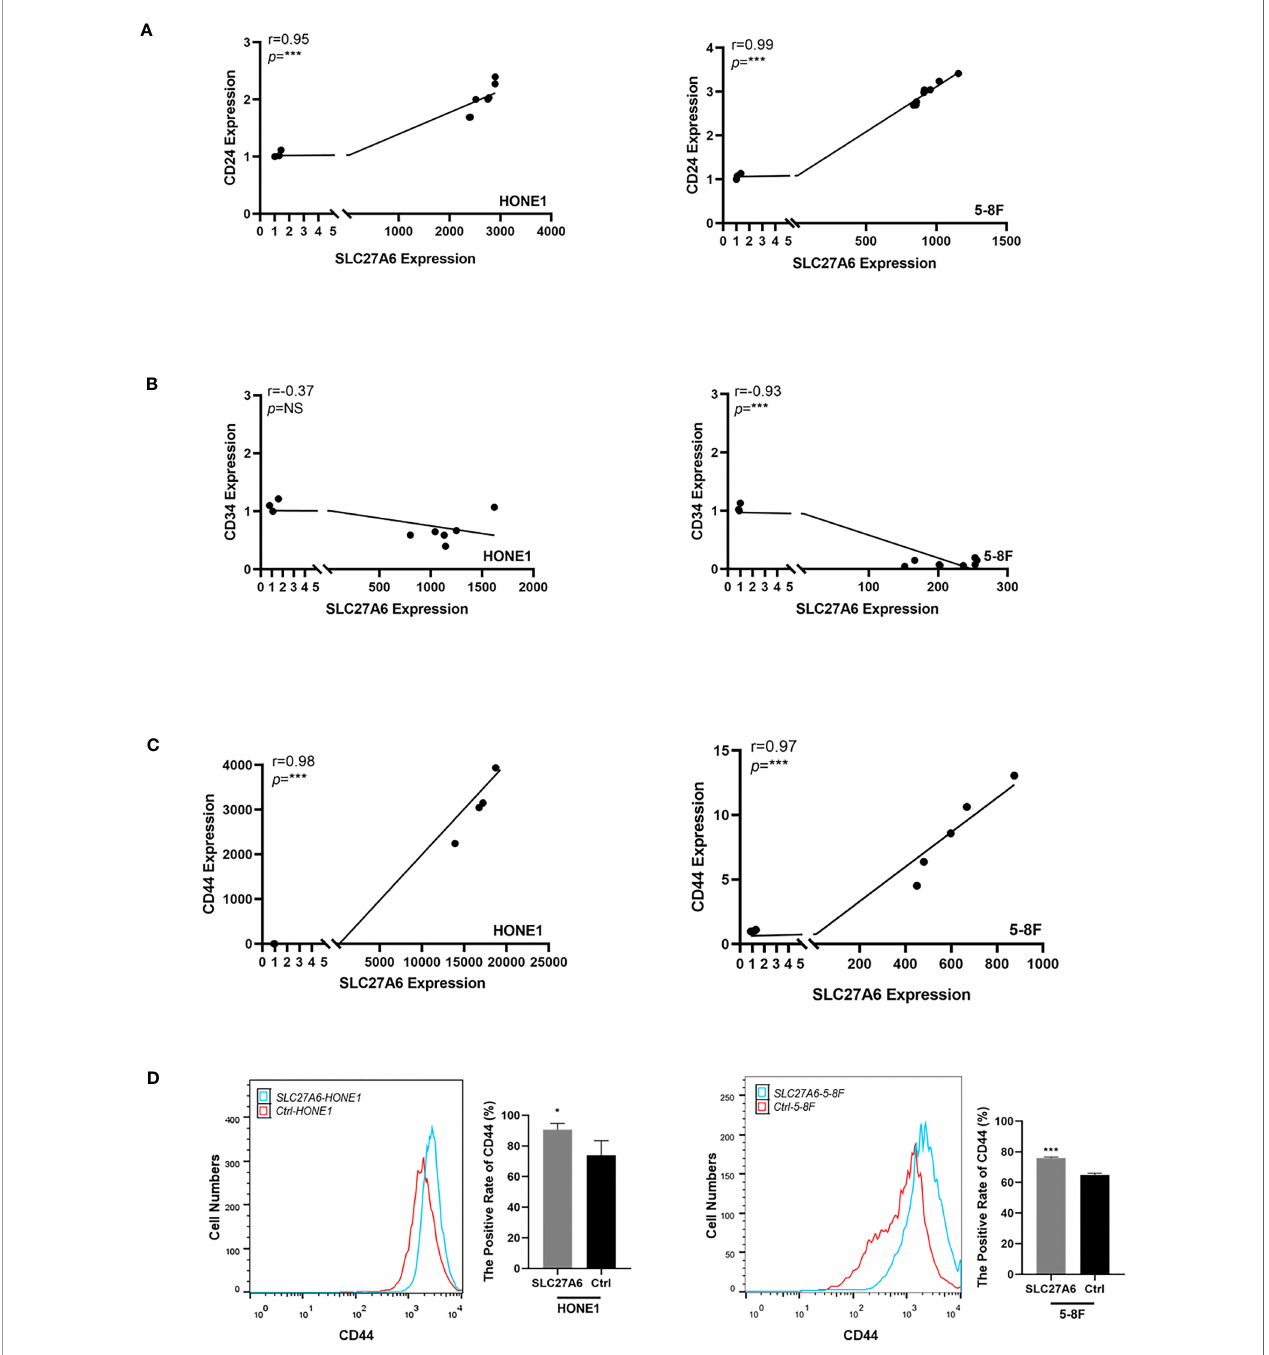
FIGURE 7 | SLC27A6 expression positively correlates with CD24 and CD44 expression level in NPC cells. (A) Positive correlation between the mRNA expression of SLC27A6 and CD24 in NPC cells (HONE1, R=0.95; 5-8F, R=0.99) by qRT-PCR. (B) No signi fi cant difference was shown between the SLC27A6 and CD34 mRNA expression in HONE1 (left panel), while a negative correlation was seen in 5-8F (right panel). (C) Positive correlation between the mRNA expression of SLC27A6 and CD44 in NPC cells (HONE1, R=0.98; 5-8F, R=0.97) by qRT-PCR. (D) The CD44 expression levels in HONE1 (left panel) and 5-8F (right panel) stably transfected cells were measured by fl ow cytometry. NS, no signi fi cance > 0.05; * P < 0.05; ** P < 0.01; *** P <